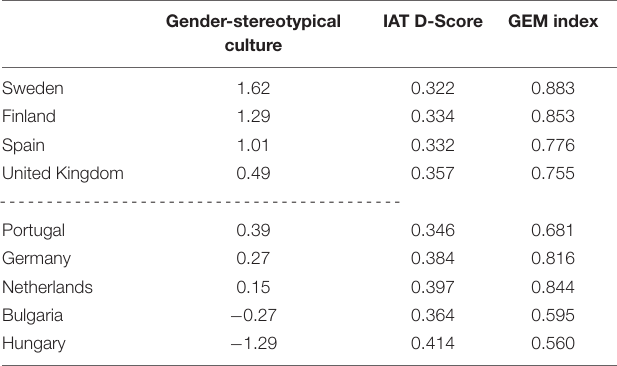
TABLE 2 | Average D-scores of Gender-Career IAT from 2014 – 2018, GEM index and combined Z-scores of IAT and GEM (gender-stereotypical culture) for countries included in